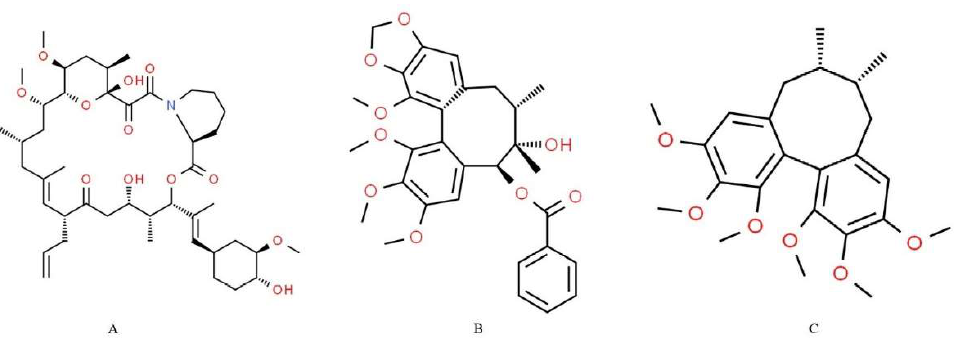
Figure 1. Structures of tacrolimus ( A ), schisantherin A (STA, B ) and schisandrin A (SIA, C ). Retrieved from ChemSpider (www.chemspider.com, accessed on 14 Febuaray.2021).